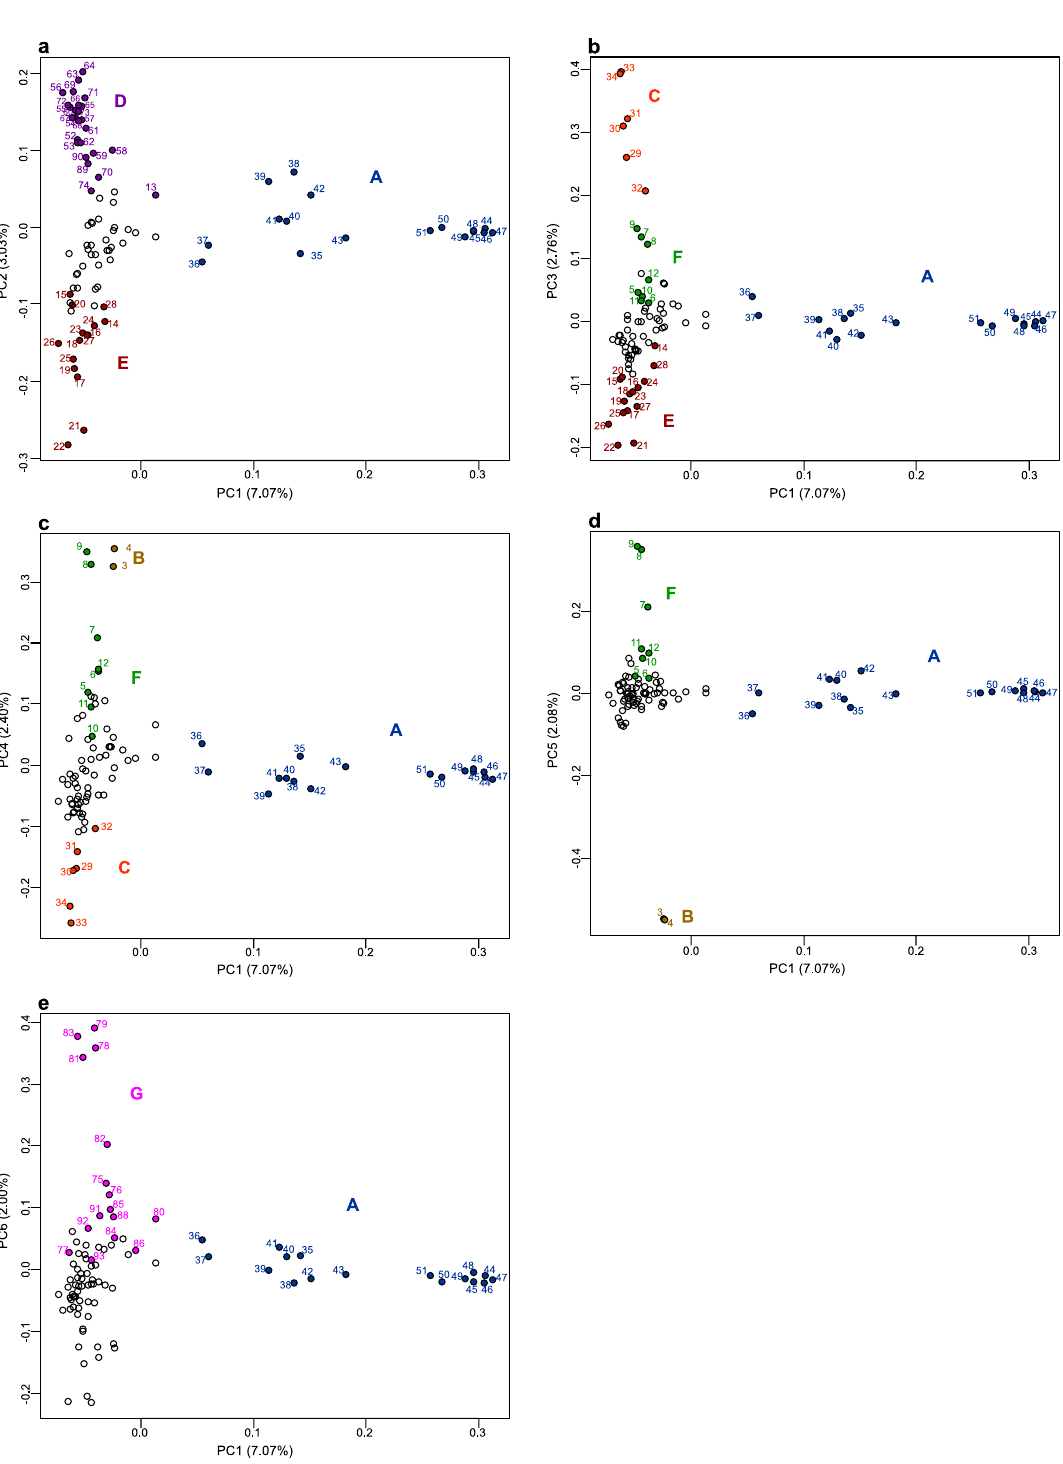
Figure 1. Principal component (PC) analysis of Zanthoxylum accessions used in the study. The six major component data are shown by the five two-dimensional data sets: ( a ) first and second PCA axes, ( b ) first and third PCA axes, ( c ) first and fourth PCA axes, ( d ) first and fifth PCA axes, and ( e ) first and sixth PCA axes. Group A of the Asakura lineage is shown in blue; group B of the Budou lineage is shown in brown; group C of the Arima lineage is shown in orange; group D of the Asakura lineage is shown in violet; group E of the Takahara lineage is shown in maroon; group F of the Arima lineage is shown in green; group G is shown in violet. The letters indicating the sample number are also shown in the same colour. The contribution rate of each principal component is shown in parentheses. Figure was generated using R software (version 3.6.2) 44